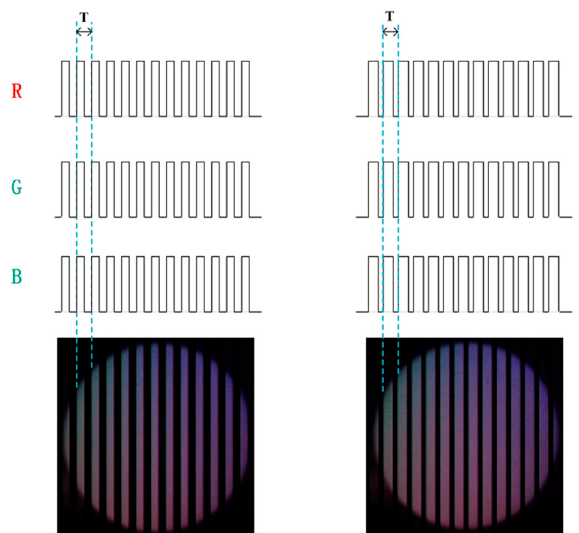
Figure 4. The effect of different encoding sequences.